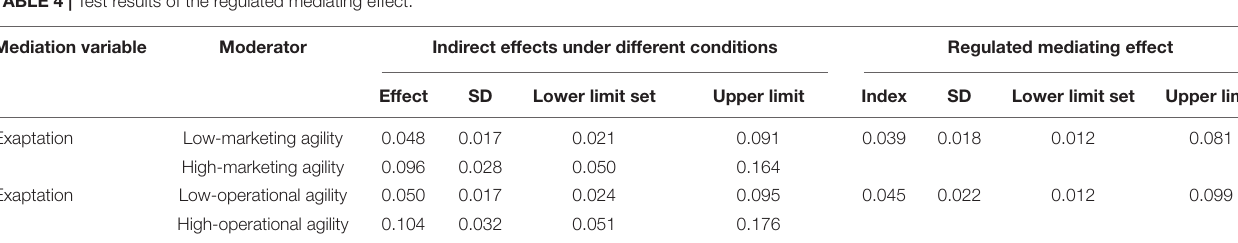
FIGURE 2 | The moderating effect of organizational agility on the correlation between resource bricolage and exaptation. TABLE 4 | Test results of the regulated mediating